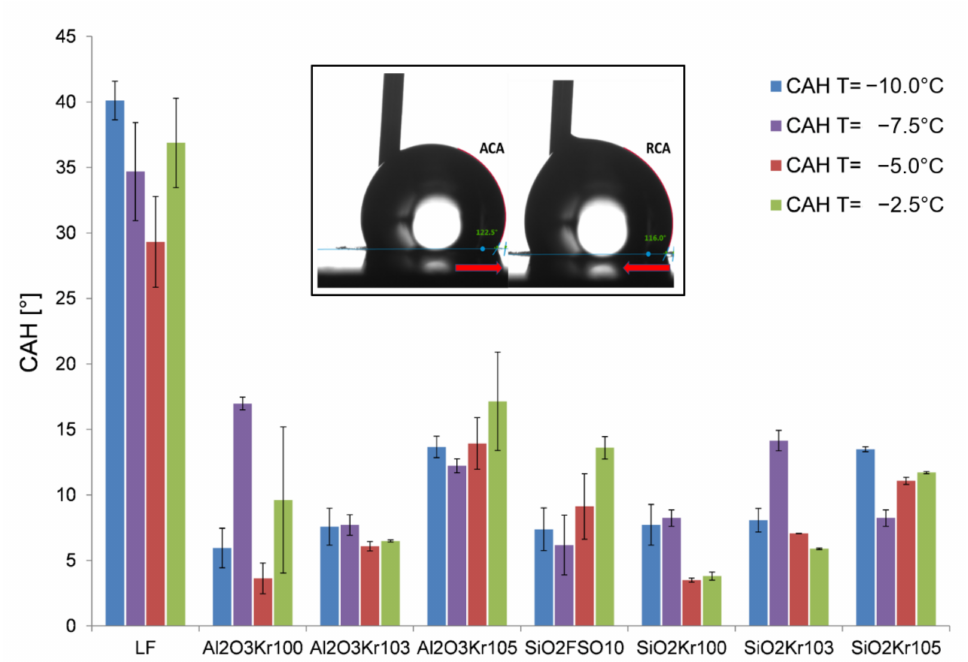
Figure 7. Contact angle hysteresis (CAH) of the surface coatings grouped by coating type. Standard deviations are reported as error bars. Drop profiles used for advancing and receding contact angle (ACA and RCA, respectively) of one of the measurements on Al2O3Kr100-infused sample are reported as